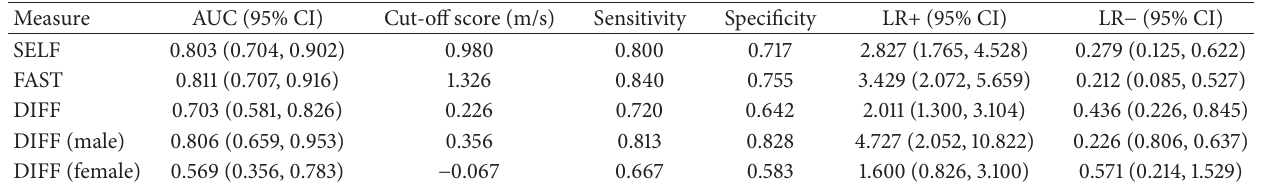
Table 5: AUC, specificity, sensitivity, and LR for ROC curve analyses of gait speeds.